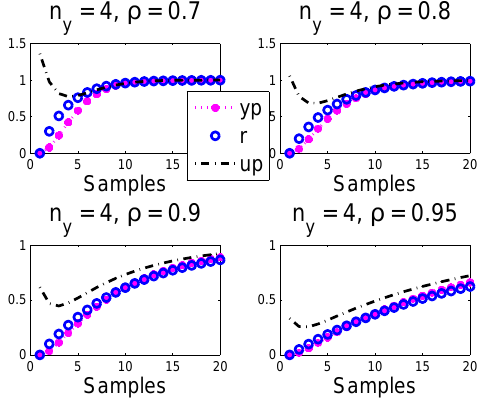
Figure 14. Closed-loop step responses for an under-damped system G overlaid with the underlying target